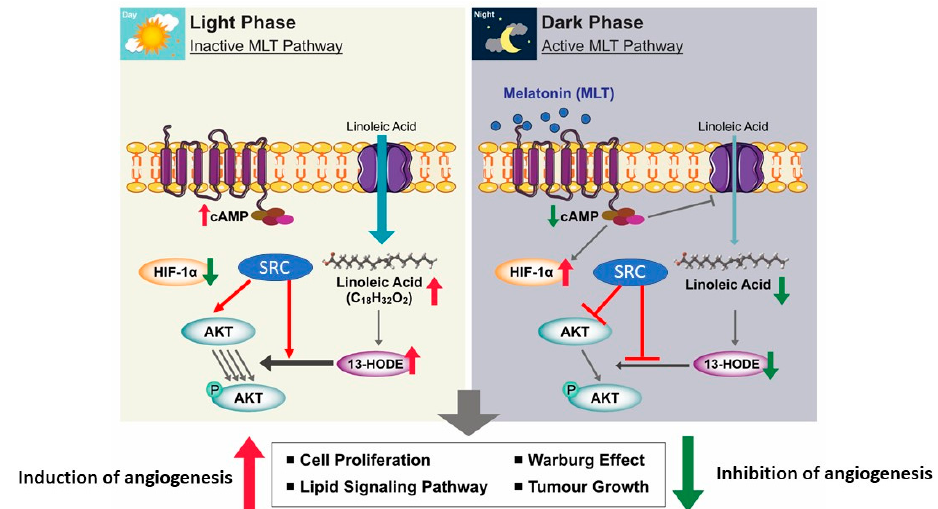
Figure 4. Differential anticancer effect of MLT in the presence and absence of light. The concept was Figure 4. Di ff erential anticancer e ff ect of MLT in the presence and absence of light. The concept was adapted and modified from Reference [148]. adapted and modified from Reference